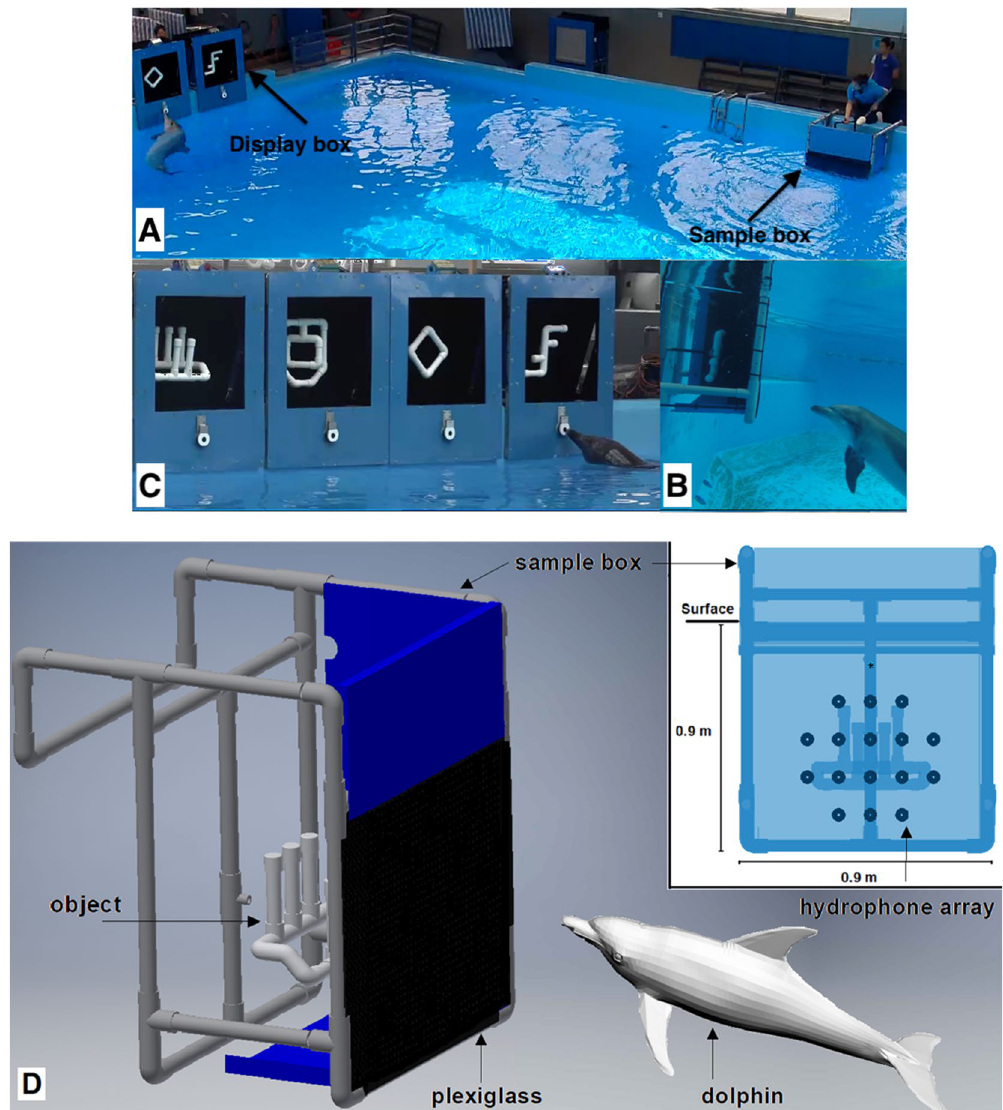
Figure 4. The echoic-to-visual cross-modal matching-to-sample experiment setup. ( A ) The positions of the sample box and display boxes. In the experiments, the resident dolphin used echolocation sense alone to inspect the sample object in the water on the right side of the pool, then swam up to the air and only used visual sense to match the sample on the left side of the pool. ( B ) Underwater echolocation inspection. The dolphin was echolocating on the object in front of the sample box under the water. ( C ) Visual matching in air. The dolphin was selecting the alternative object. ( D ) A 3D illustration of the experiment setup under the water. An acoustically transparent thin plexiglass (indicated in black colour in the 3D figure) was mounted on the front side of the sample box to ensure that dolphin cannot see the object inside the box. A planar hydrophone array with 16 hydrophones was placed right behind the plexiglass. A sample object was concealed in the sample box. The distance from the sample object to the dolphin was about 1 m. The recorded experiment processes are provided in Supplementary Video